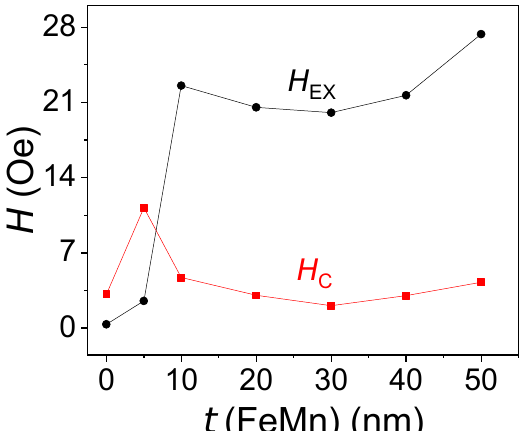
Figure 9. Dependences of the exchange bias and coercivity for easy axis on the antiferromagnetic layer